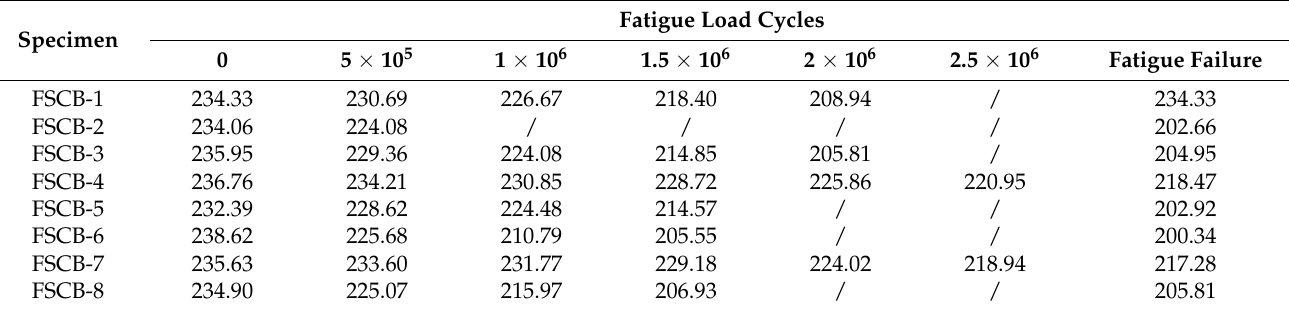
Table 6. Measured force at the middle support during the fatigue load process (unit: